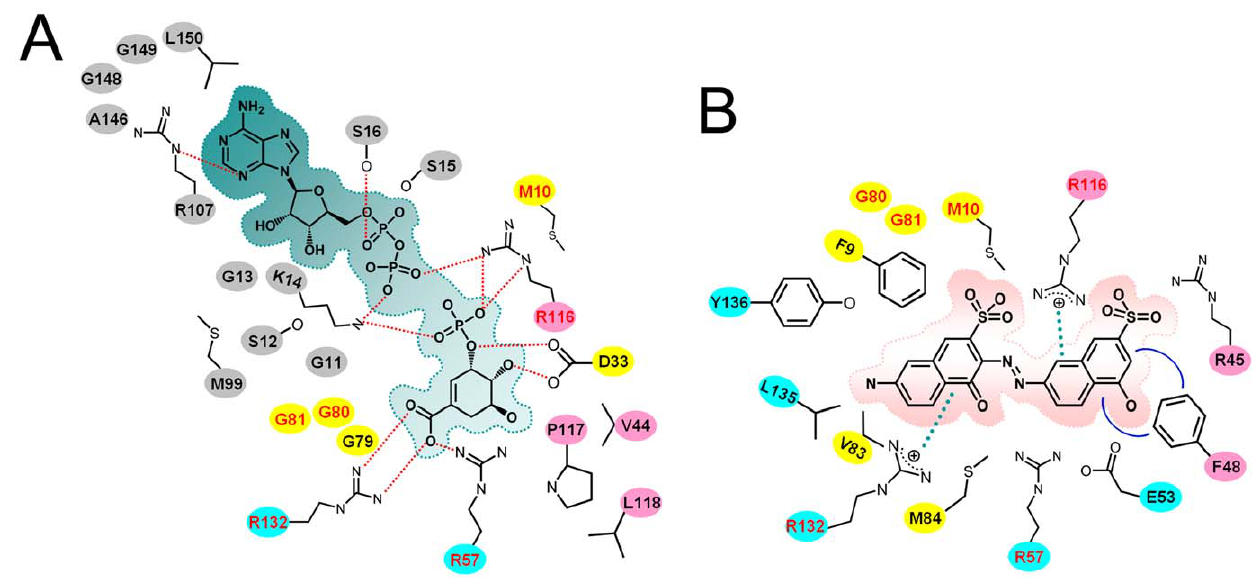
Figure 4. Schematic illustration of HpSK ? S3P ? ADP and E114A ? 162535 binding pockets. (A) Residues that contact S3P and ADP in HpSK ? S3P ? ADP. Red dashed lines denote hydrogen-bonding interactions. (B) Residues that contact NSC162535 in E114A ? 162535. Dotted green lines and blue curves are cation- p and p - p interactions, respectively. Residues from three HpSK ? shikimate ? PO 4 subsites, C X , O CORE , and O LID [33], are colored by cyan, yellow, and pink, respectively. Residues from the nucleotide site are colored by